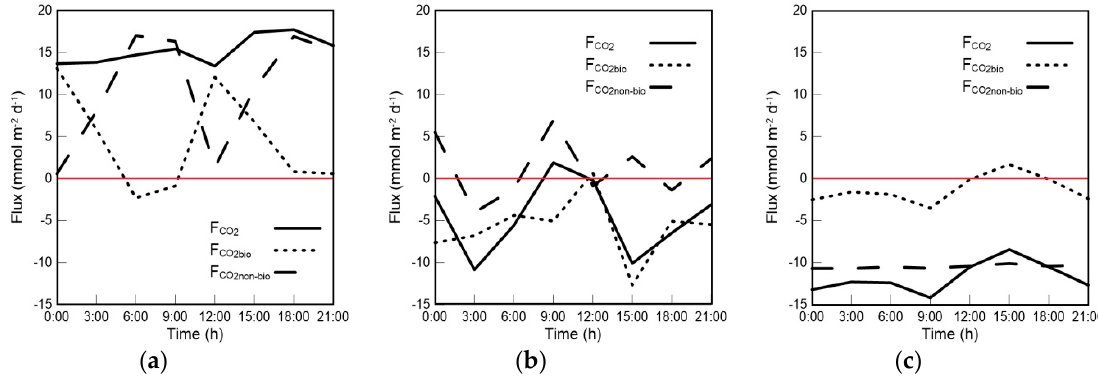
Figure 6. Twenty-four hour variations in F CO2 , F CO2bio , and F CO2non-bio in the near-shore ( a ), front ( b ), and offshore ( c ) regions in summer.